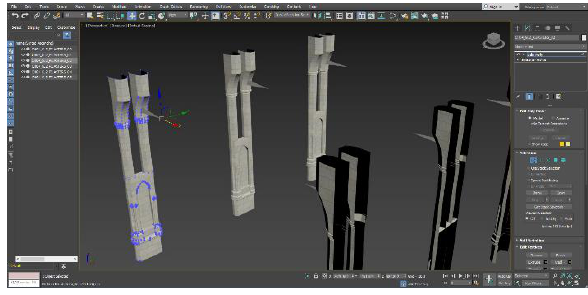
Figure 7. Correctly instanced components ready for Unity.